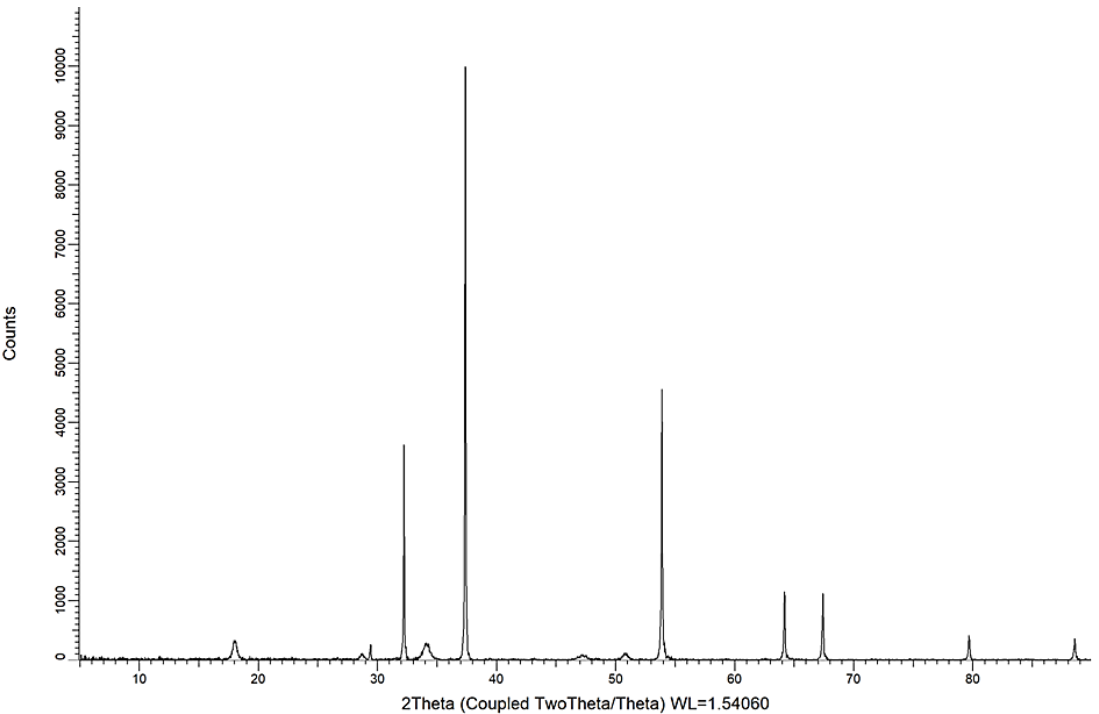
Figure 12. The XRD pattern of CaO powder.